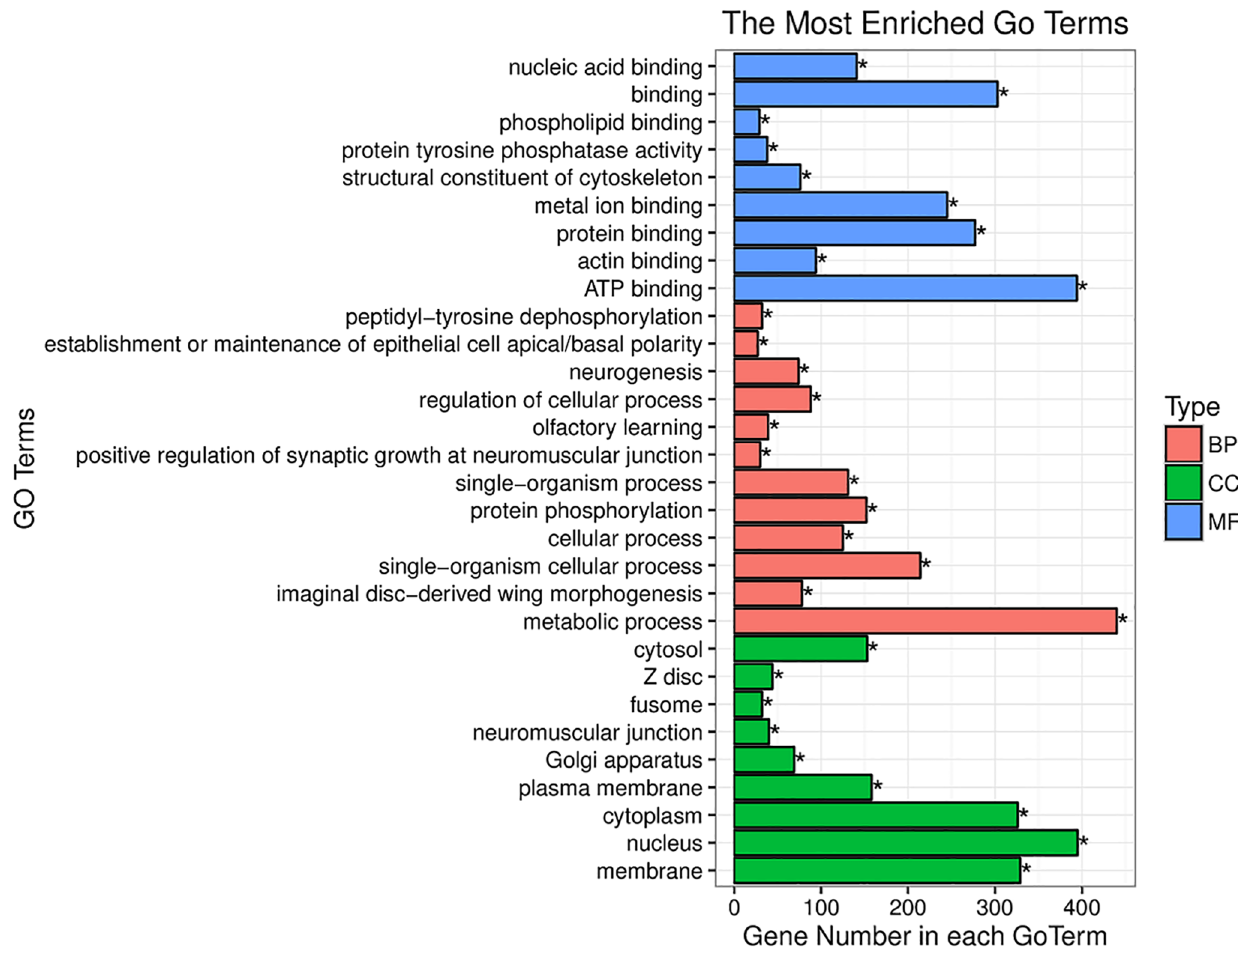
Fig 4. GO analysis of target genes of differently